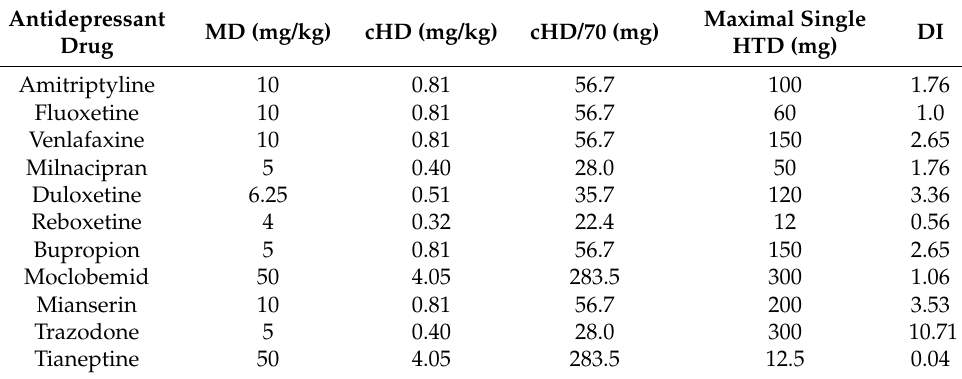
Table 3. Conversion of minimal doses of antidepressant drugs affecting the action of antiepileptic drugs against MES in mice to human doses.